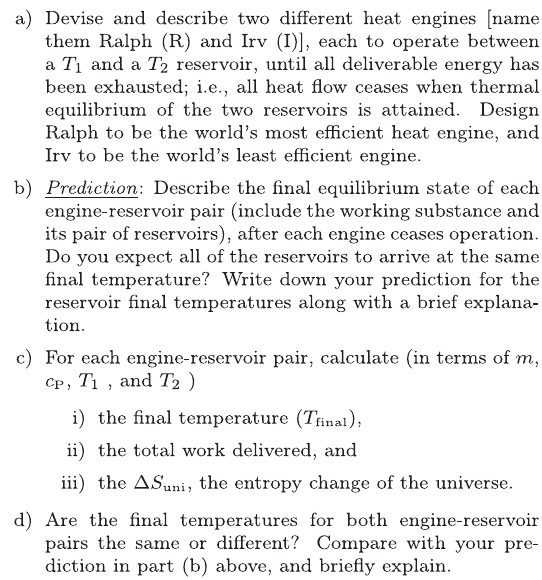
FIG. 3. The finite reservoirs question (FRQ). Designed based on Carter ’ s problem 7.8 [8] and Baierlein ’ s problem 3.6 [37]. Given as a homework assignment in Thermo and in Stat